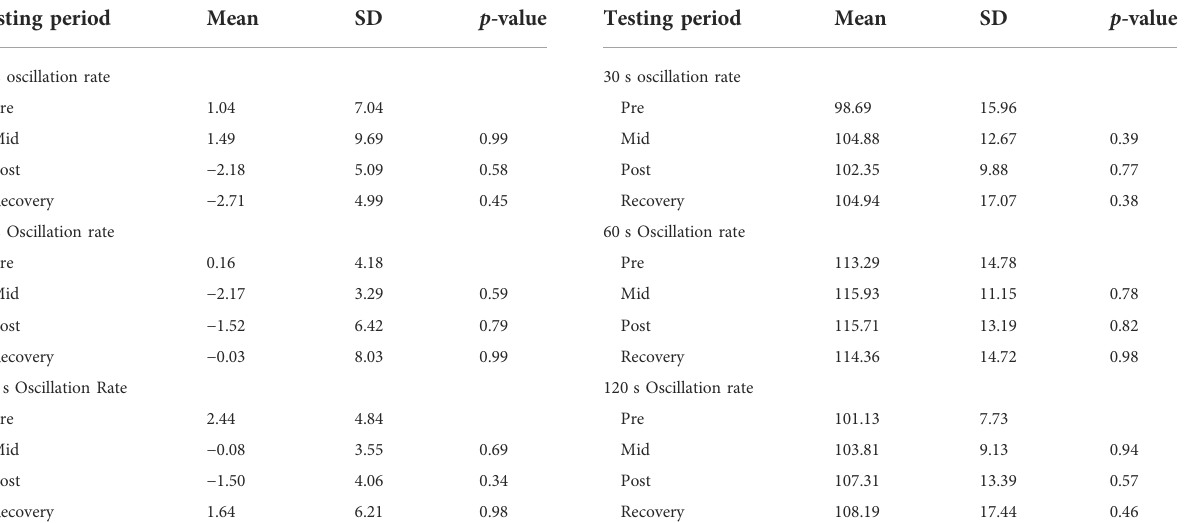
TABLE 7 Thein fl uenceof30 s,60 s,and 120 soscillations of80/20and 30/70 O2/N2 concentrations on arterial partial pressure of